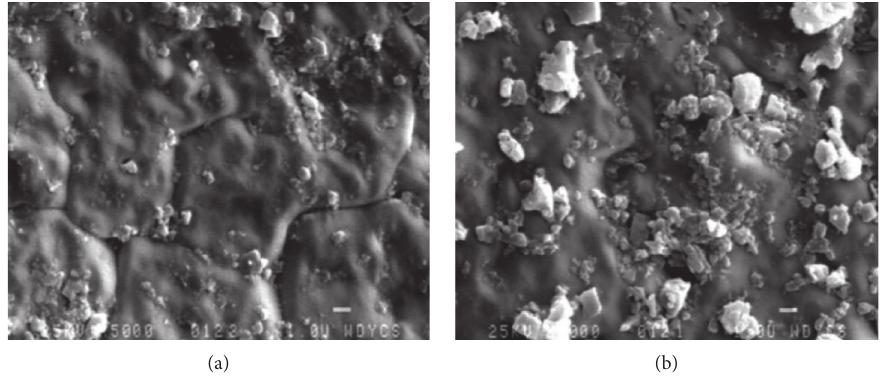
Figure 4: SEM images of (a) Yunying salt rock and (b) Jintan salt rock [39].